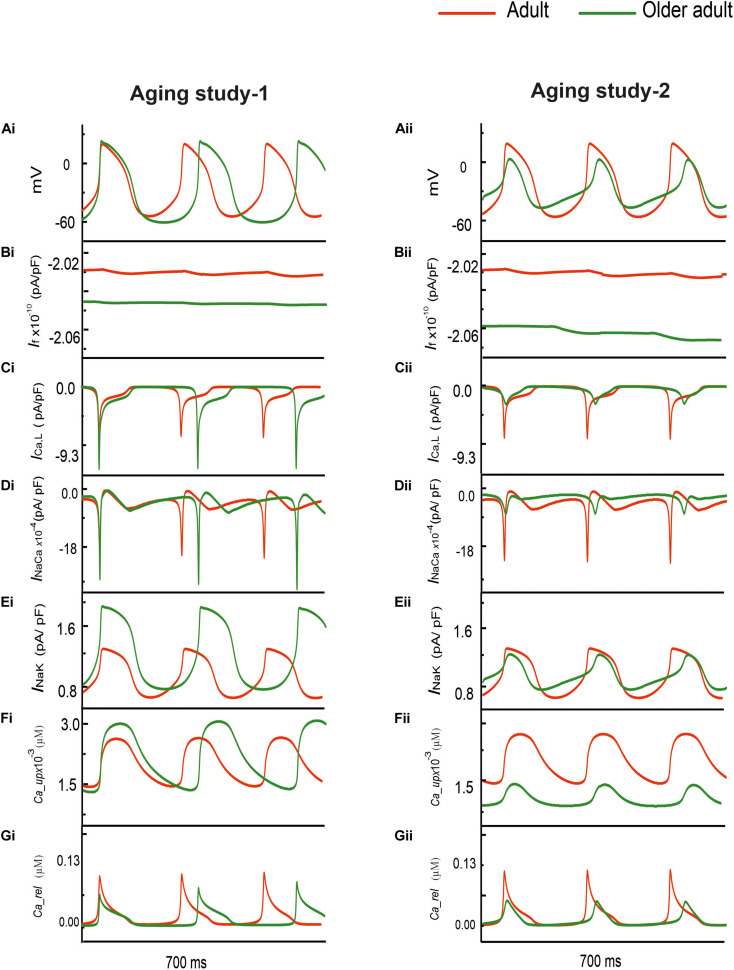
(Ai,Aii) Action potentials computed from rat SAN myocyte model in adult (red) and older adult (green) conditions using the Aging Study-1 (left panels) and Aging Study-2 (right panels) datasets. Simulations were conducted by using the rat SAN cell model developed by Tao et al. (2011). (Bi–Gi,Bii–Gii) Underlying ionic channel currents and Ca2+-handling during APs: If, ICaL, INaCa, INaK, Ca2+ uptake and Ca2+ release.